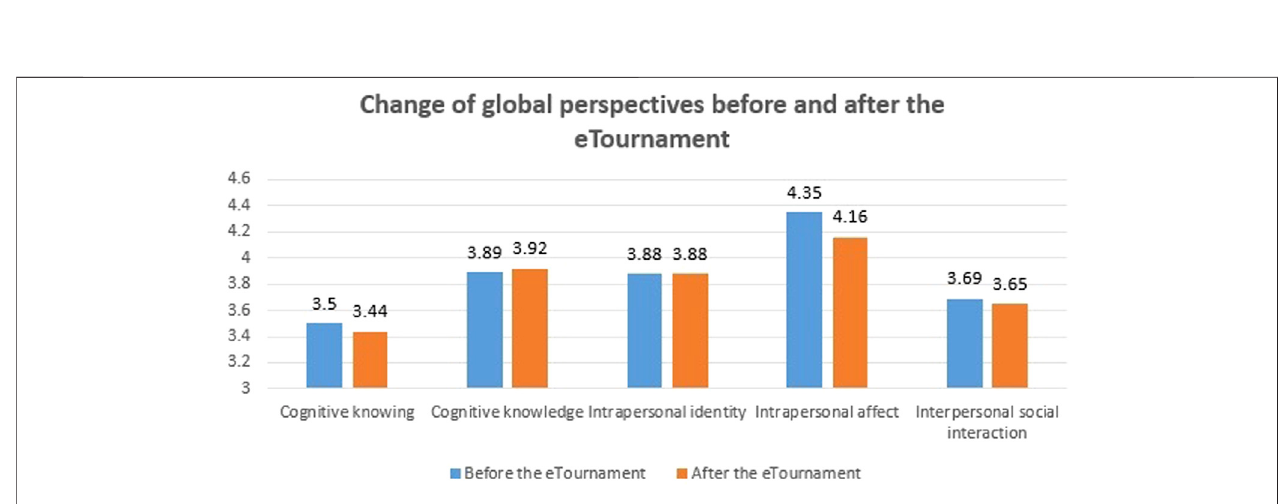
FIGURE 6 | Change of global perspectives before and after the